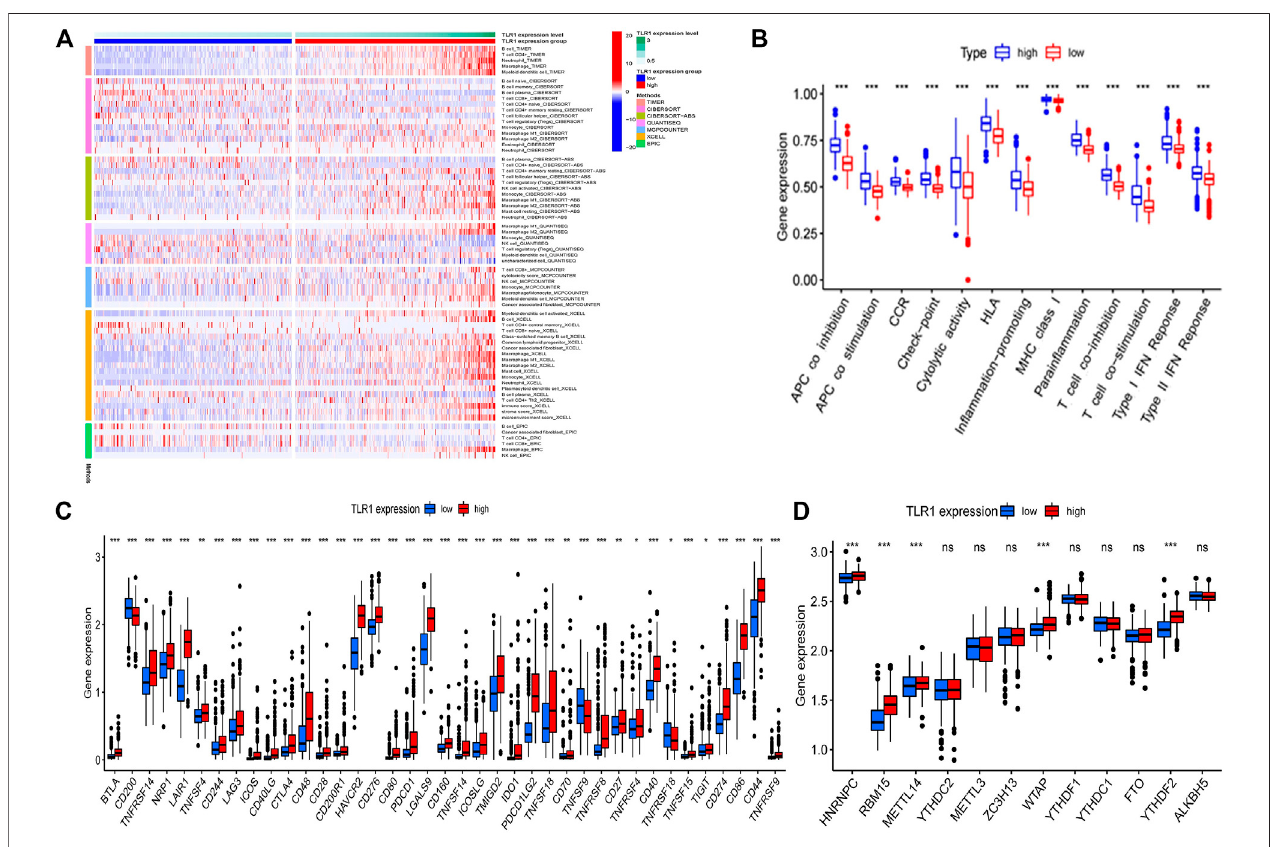
FIGURE 6 | The Correlation of TLR1 expression with immune in fi ltration level in LGG. (A) the heatmap of immune responses based on different algorithms. (B) ssGSEA for the association between immune cell subpopulations and related functions. (C) immune checkpoints expression among the high and low groups. (D) The expression of m6A-related genes between high and low TLR1 risk